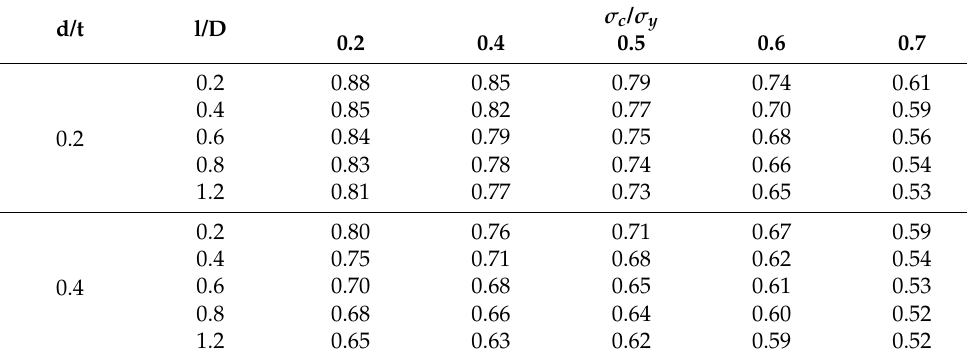
Table 9. FEA on corroded pipeline with single corrosion defect subjected to internal pressure and longitudinal compressive